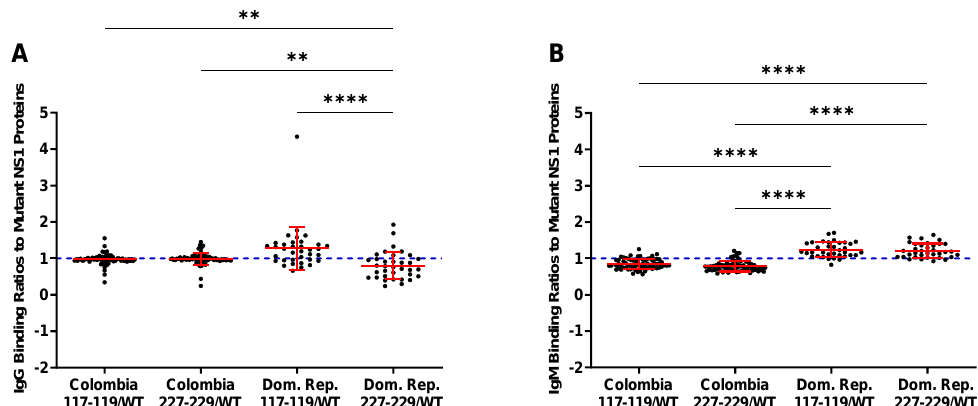
Figure 3. Ratios of mutant vs. wild-type binding of NS1 by patient samples. The blue line at 1 indicates equal binding. Numbers over 1 indicate increased binding to the named mutant, while under 1 indicate increased wild-type binding. ( A ): Ratios of mutant/wild-type binding from IgG in samples show preferential binding to 117–119 mutant NS1. ( B ): IgM shows preferential binding of mutant NS1 proteins in samples from the Dominican Republic. Colombia = Colombia samples from suspected ZIKV infection. Dom Rep = Dominican Republic samples from suspected ZIKV infection. 117–119 = ZIKV NS1 W117A, G118A, K119A. 227–229 = ZIKV NS1 H227A, T228A, L229A Comparisons were made using Kruskal–Wallis ANOVA. Asterisks represent significant comparisons (**** p < 0.0001; ** p < 0.01). The full dataset is presented in Table S3.